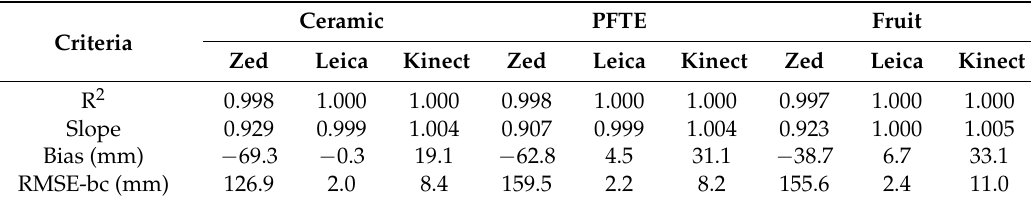
Table 2. Measurement of object distance using three low cost technologies for different materials over the range 0.6–5.4 m. RMSE-bc refers to bias-corrected root mean square errors (mm).